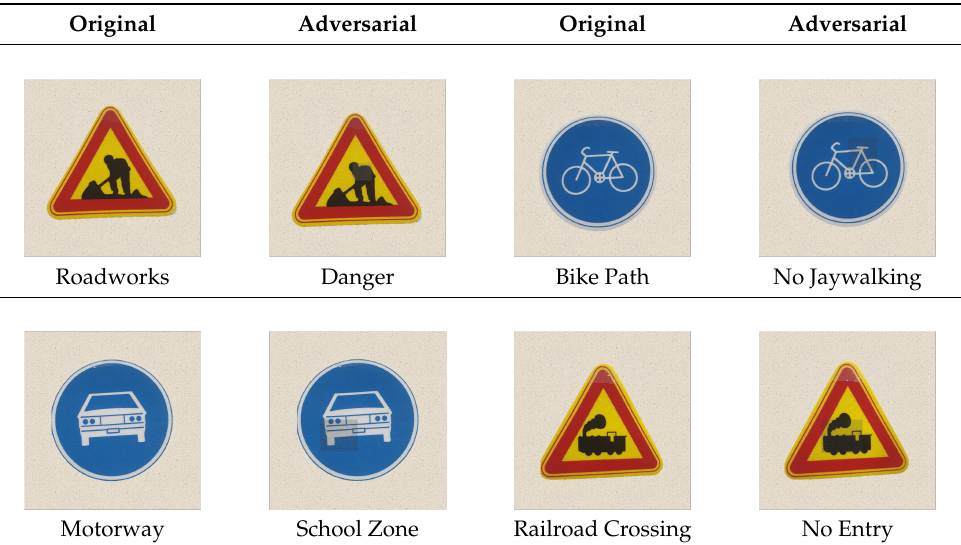
Table 4. The physical-world attack result examples of traffic sign mock ups with and without adversarial patches generated by